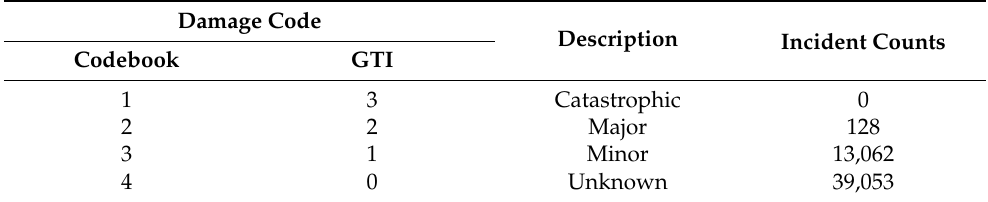
Description Incident Counts